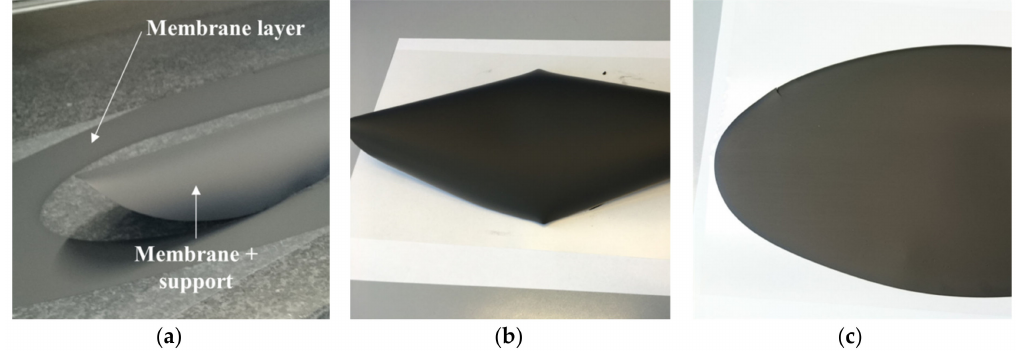
Figure 7. Green tapes obtained by using powder D after drying: ( a ) Slurry 1 (reference amount of PEG400); ( b ) Slurry 2 ( + 100% PEG400); ( c ) Slurry 3 ( + 167%